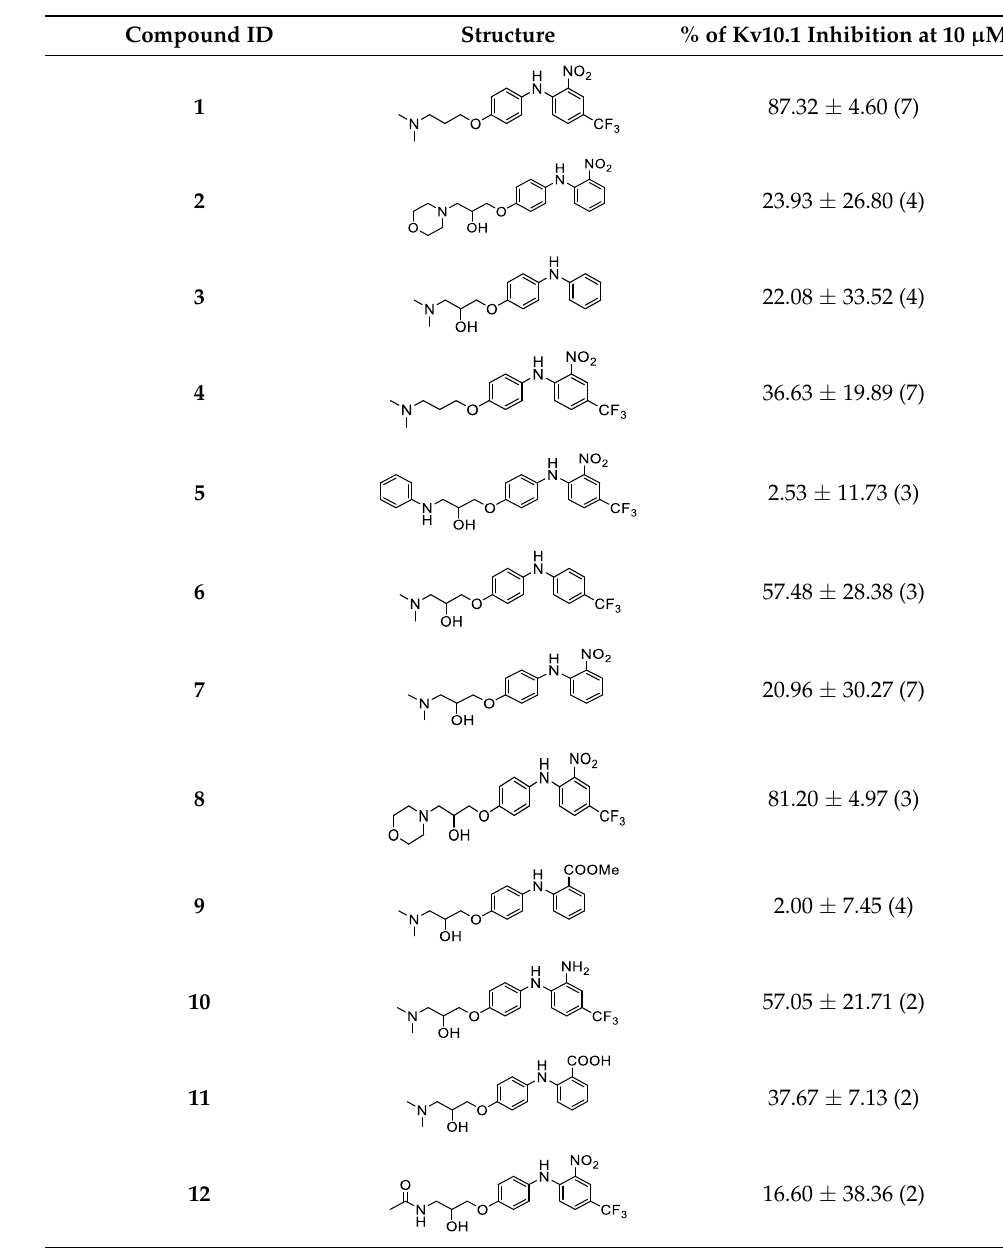
Inhibition data are means ± standard error (or range) for the number of independent experiments indicated in parentheses.